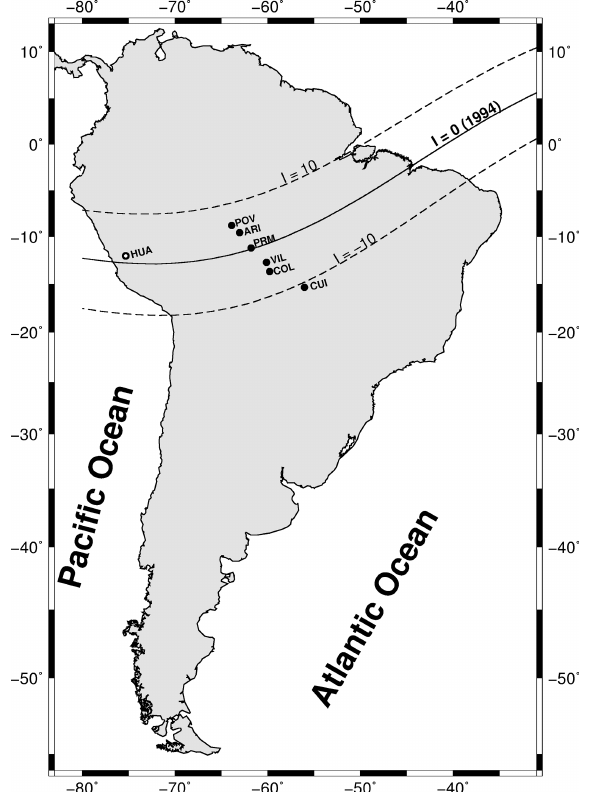
Figure 1. Geographic location of the six geomagnetic stations in South America and contours of the geomagnetic field in 1994. The solid line shows the dip equator ( I = 0 ◦ ), and the dashed lines rep- resent ± 10 ◦ inclination angles. Location of the Huancayo station (HUA) is also indicated. Geomagnetic field values were obtained from the IGRF